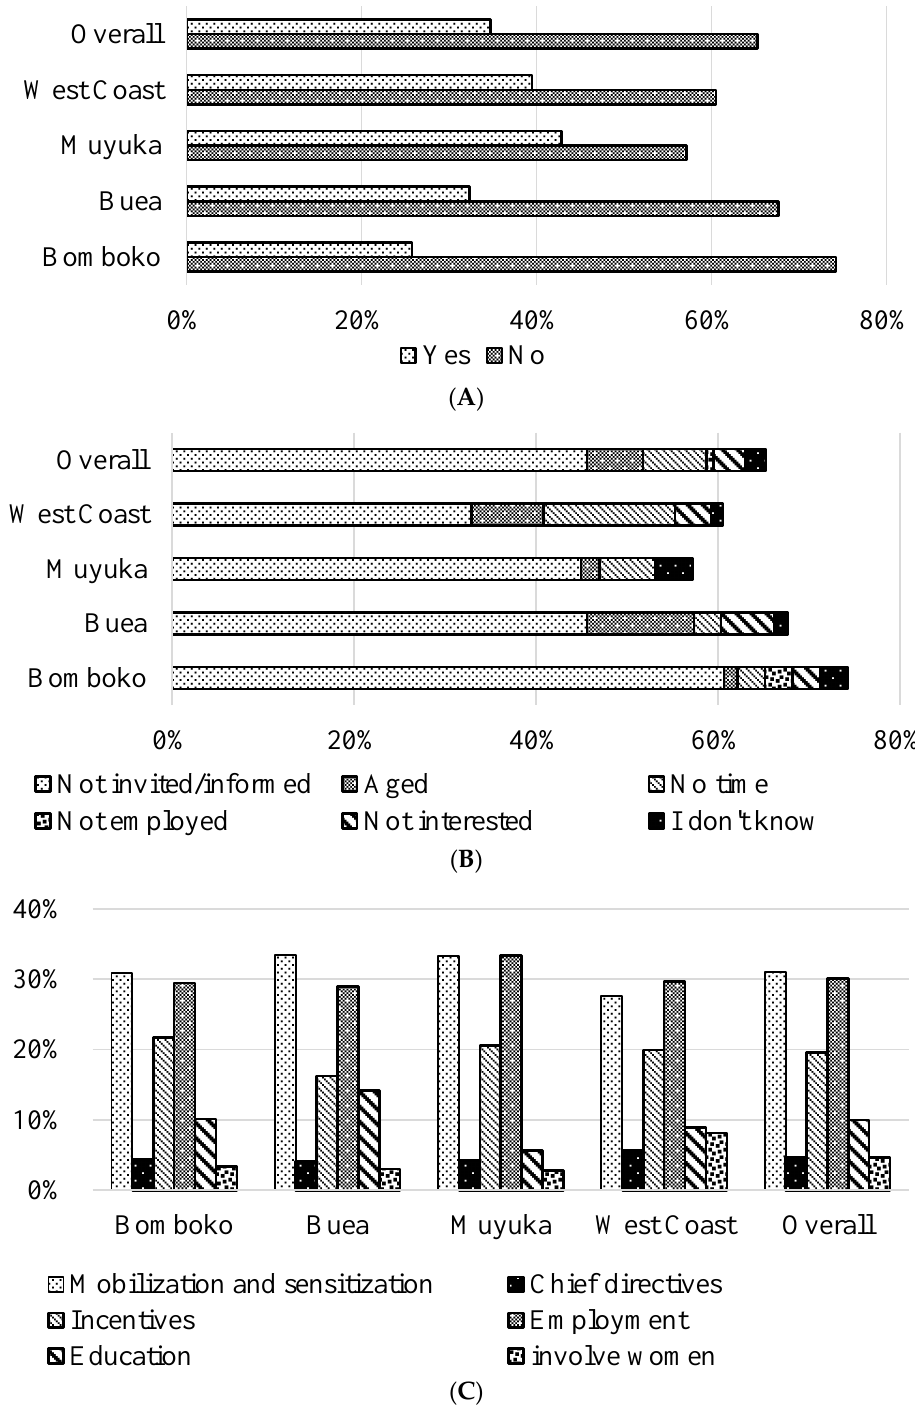
Figure 9. Percentages of local communities’ member that have ever participated ( A ), reasons for not participating ( B ) and ways to enhance participation ( C ) in MCNP activities.